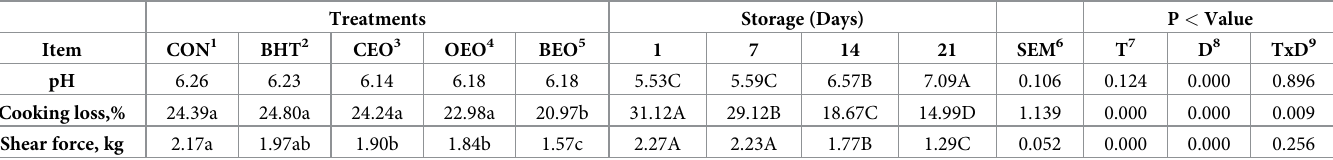
Table 4. Effect of BHT, copaiba and oregano essential oil or blend of essential oils on pH, cooking losses and shear force of beef patties during storage. Treatments Storage (Days) P < Value